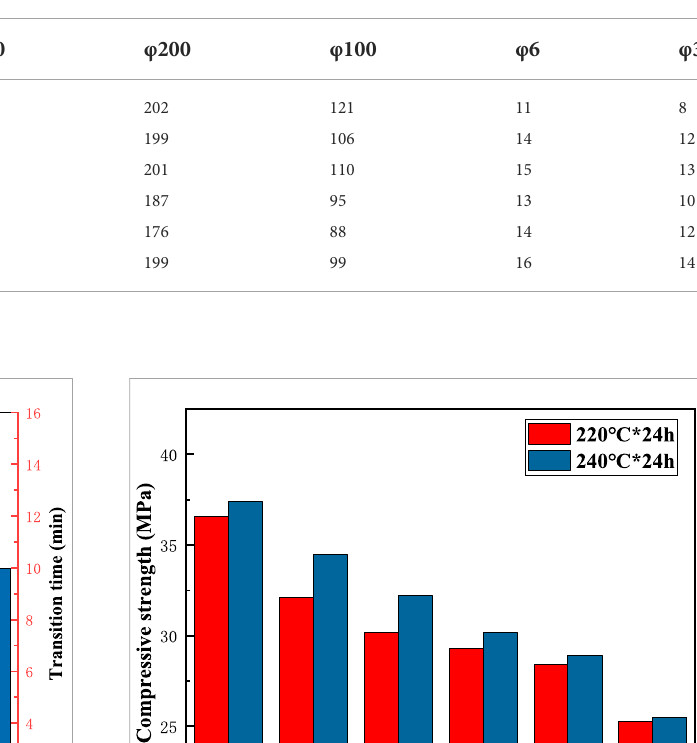
TABLE 5 Rheological properties of multicomponent composite anti-corrosion cement slurry system under different densities. Cement slurry density